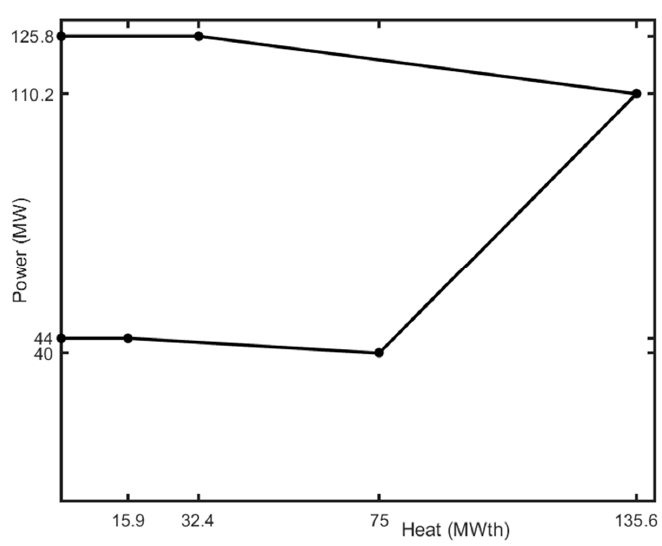
Figure 6. Feasible operating area of Heat-power in unit 3.